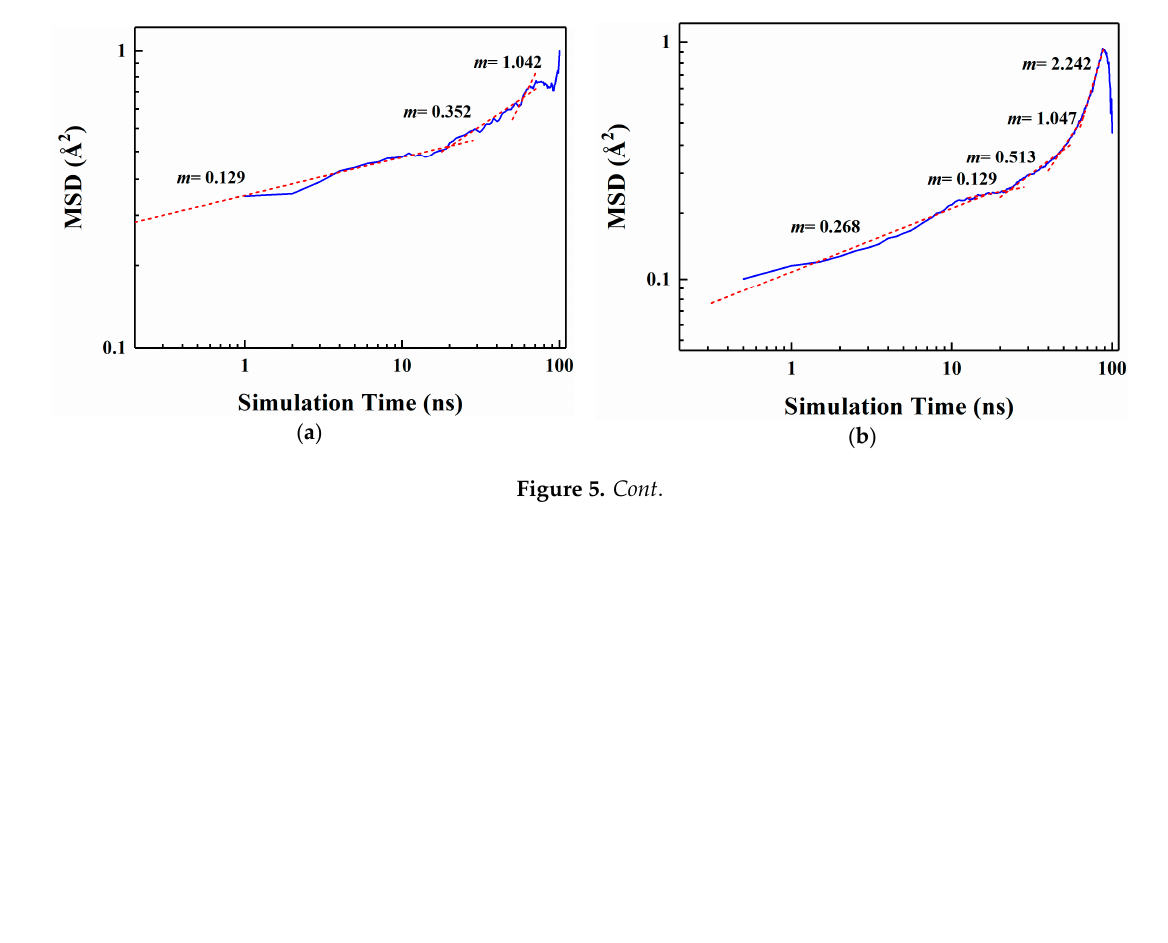
Figure 4. Mean square displacement (MSD) curves of five flavor organic molecules in PE.